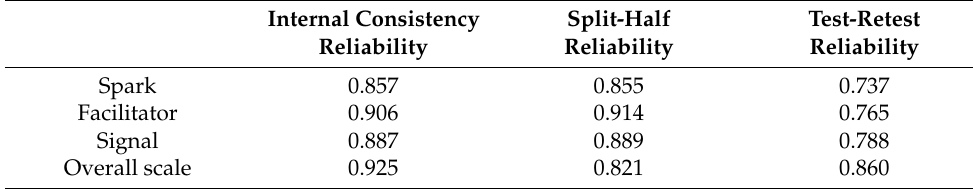
Table 12. Reliability Test of the 14